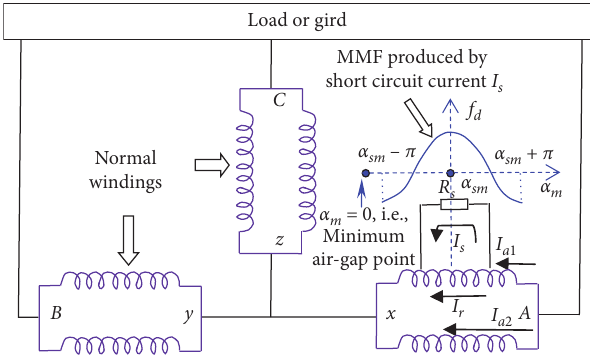
Figure 1: Diagrams of